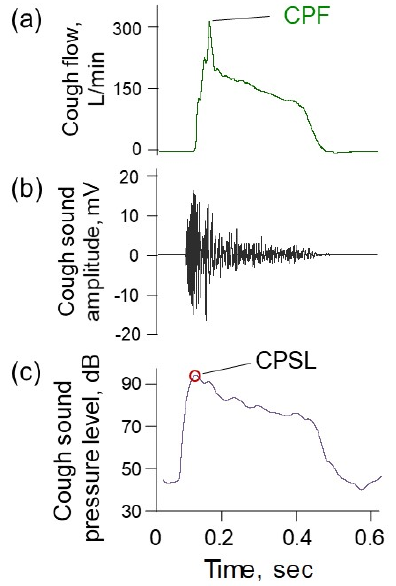
Figure 4. Examples of cough flow and cough sound in a young healthy participant [56]. ( a ) Cough flow. The green line represents the cough flow measured by a flow sensor (Mobile aeromonitor AE-